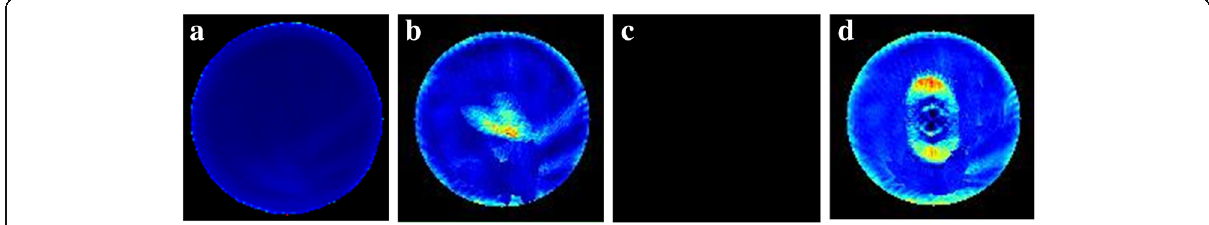
Fig. 10 Reconstruction images of concrete phantoms: a reconstrucion image of phantom A, b reconstrucion image of phantom B, c reconstrucion image of phantom C, d reconstrucion image of phantom